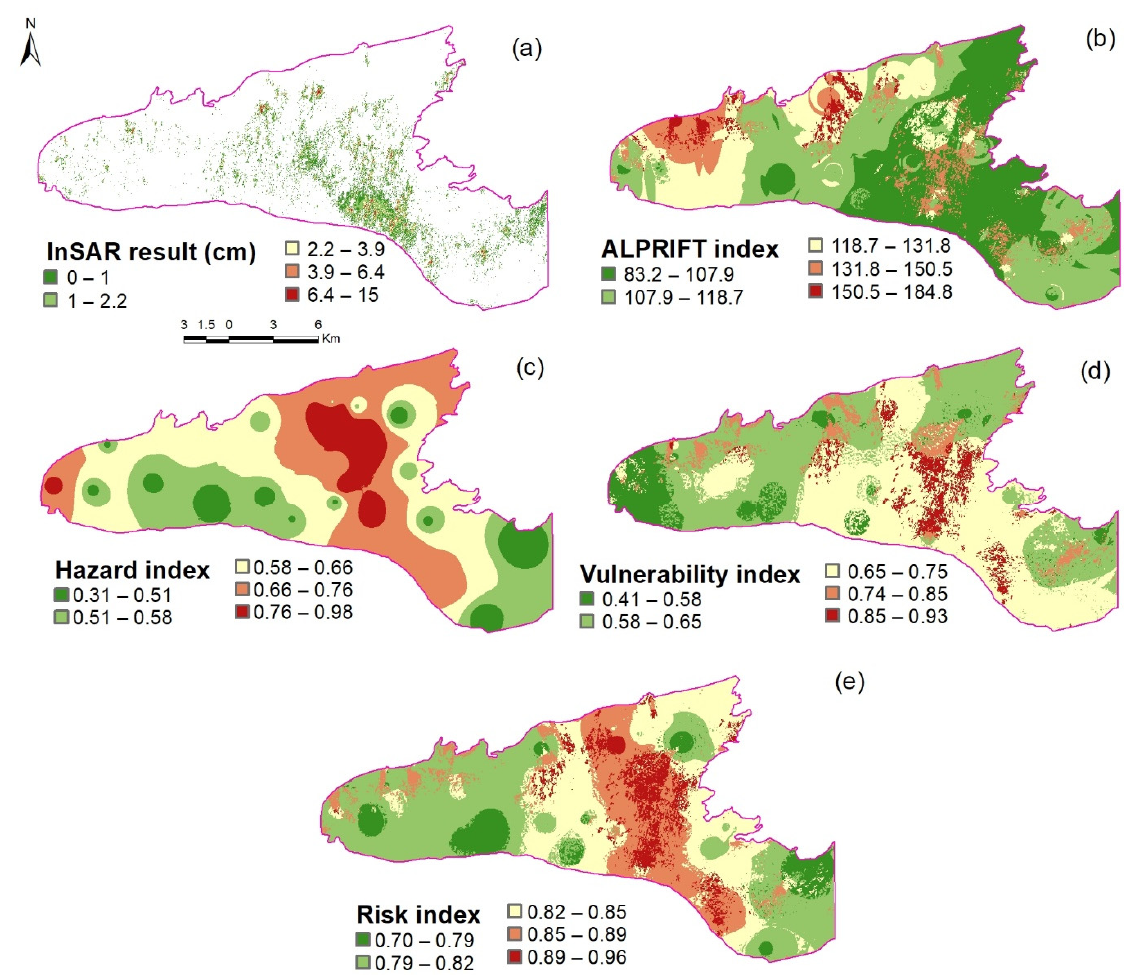
Figure 4. ( a ) InSAR result; ( b ) basic ALPRIFT; ( c ) hazard at Level 1; ( d ) vulnerability at Level 1; ( e ) risk at Level 1.